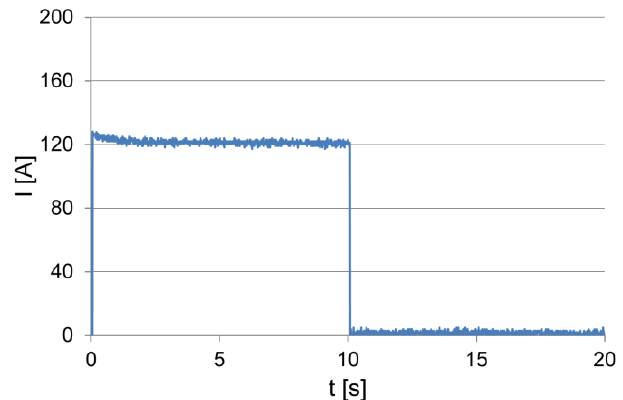
Figure 1. The current drawn from the battery.